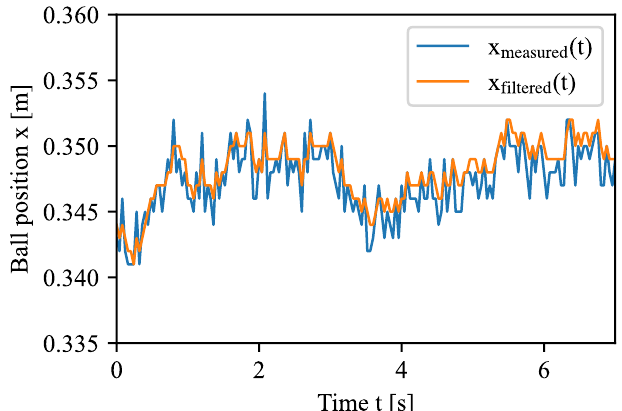
Figure 10. An application of Kalman filter in task of ball’s position x ( k )